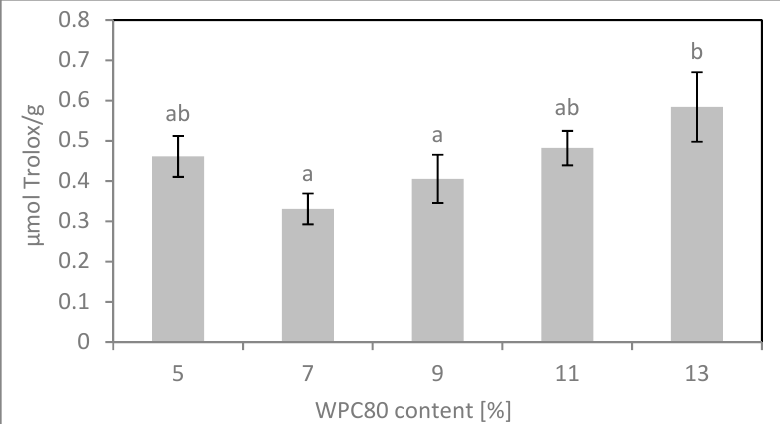
Figure 5. E ff ect of di ff erent WPC80 contents on ferric reducing antioxidant power (FRAP) of high-protein Figure 5. Effect of different WPC80 contents on ferric reducing antioxidant power (FRAP) of high- fat-free dairy desserts. Letters (a–b) indicate significant di ff erences at p < 0.05 (Tukey’s HSD protein fat-free dairy desserts. Letters (a–b) indicate significant differences at p < 0.05 (Tukey’s HSD test).